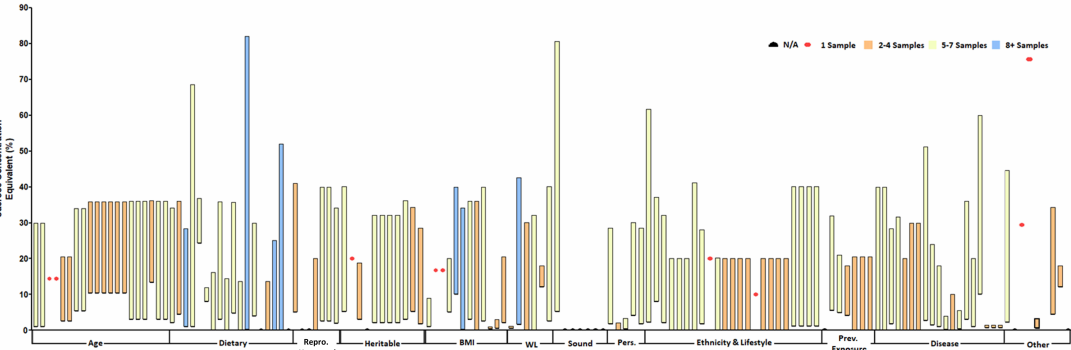
Figure 4. Sweetness levels (sucrose concentration equivalents) tested across studies. Each study’s reported sweetness level (i.e., a single sweet food / beverage set tested) or range (i.e., more than one sweetness level assessed for a food / beverage set) is represented by vertical bars, as sucrose equivalents, for each distinct